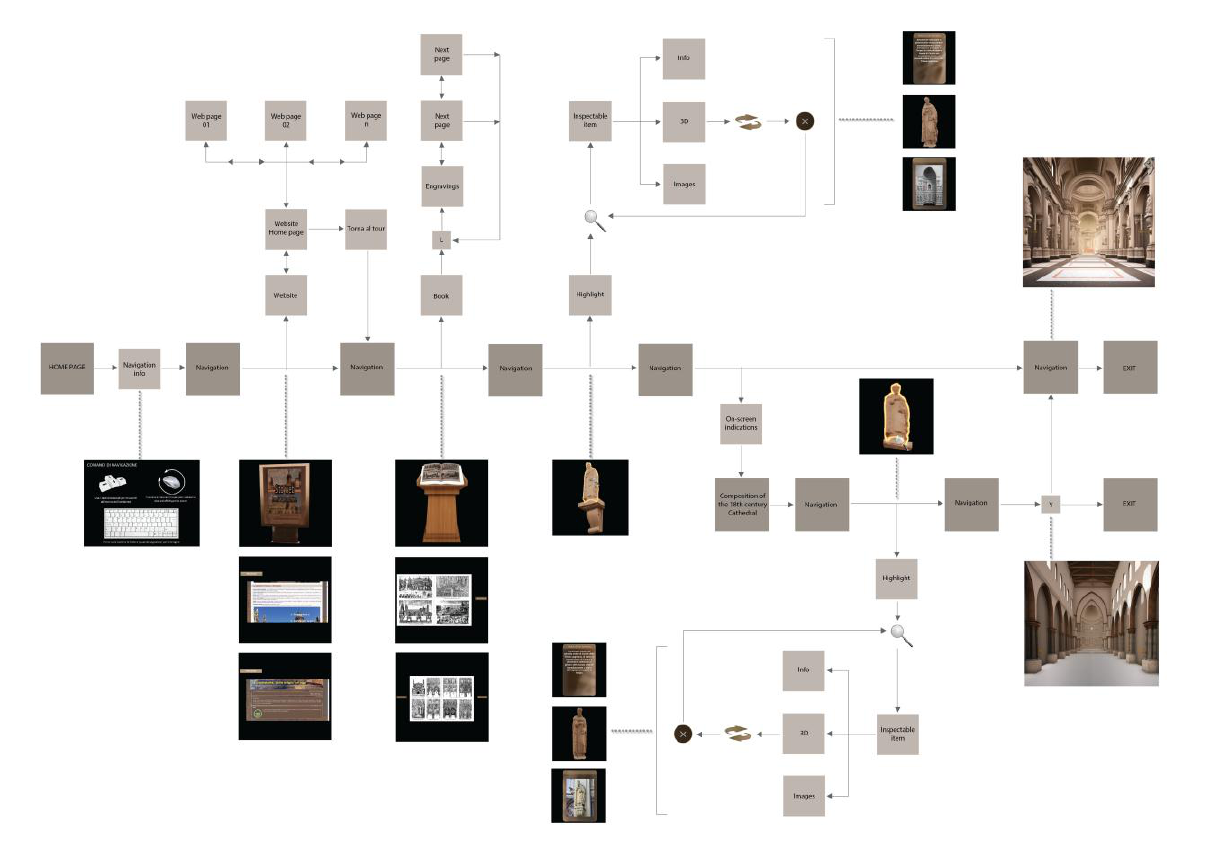
Fig. 13: Taxonomic scheme of actions and User